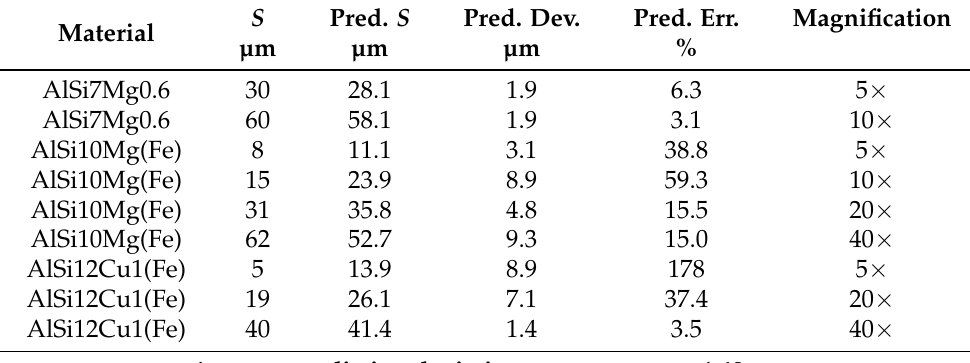
Table 4. Results of prediction for materials not used during